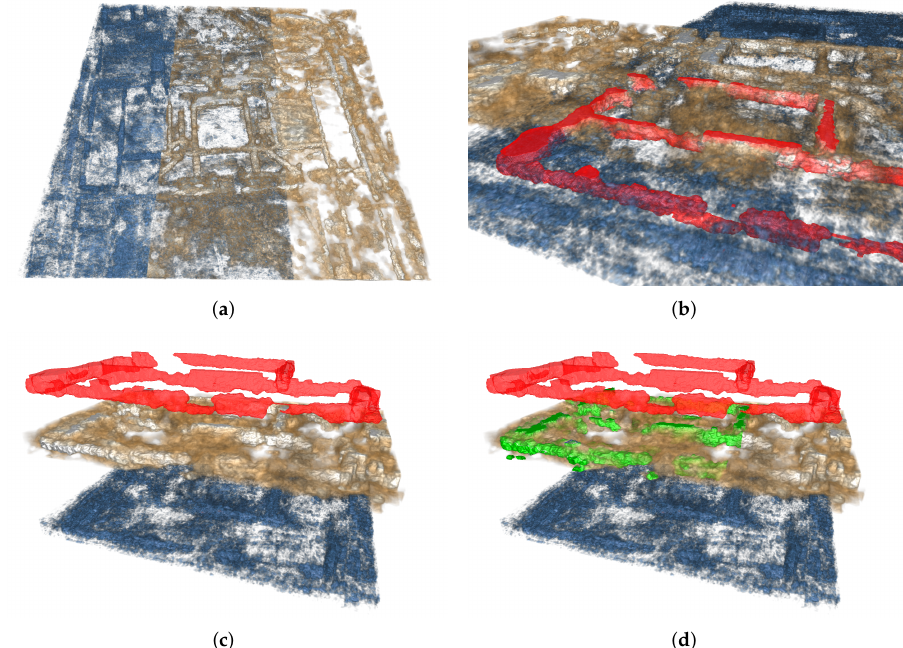
Figure 12. Visualization results overview: Multi-volume DVR based on partially overlapping sub- volumes of the unfiltered (blue) and TV-L1 filtered (brown) Carnuntum dataset. In the overlap region, the visual contributions are combined. The floor plan remains clearly recognizable, details lost during filtering are supplemented from the unfiltered dataset ( a ). Integration of a semi-transparent segmentation result displayed in red emphasizing the walls of the segmented building. In the unfiltered region the superimposition with the segmentation supports the structural analysis of the walls ( b ). Spatial separation in, e.g., vertical direction reduces occlusion and is therefore useful for illustrating results of GPR data analysis ( c ). Likewise, including iso-surface visualization of the filtered dataset may be used to highlight regions of high radar reflectivity. In our case, there is a good match with the segmented walls ( d